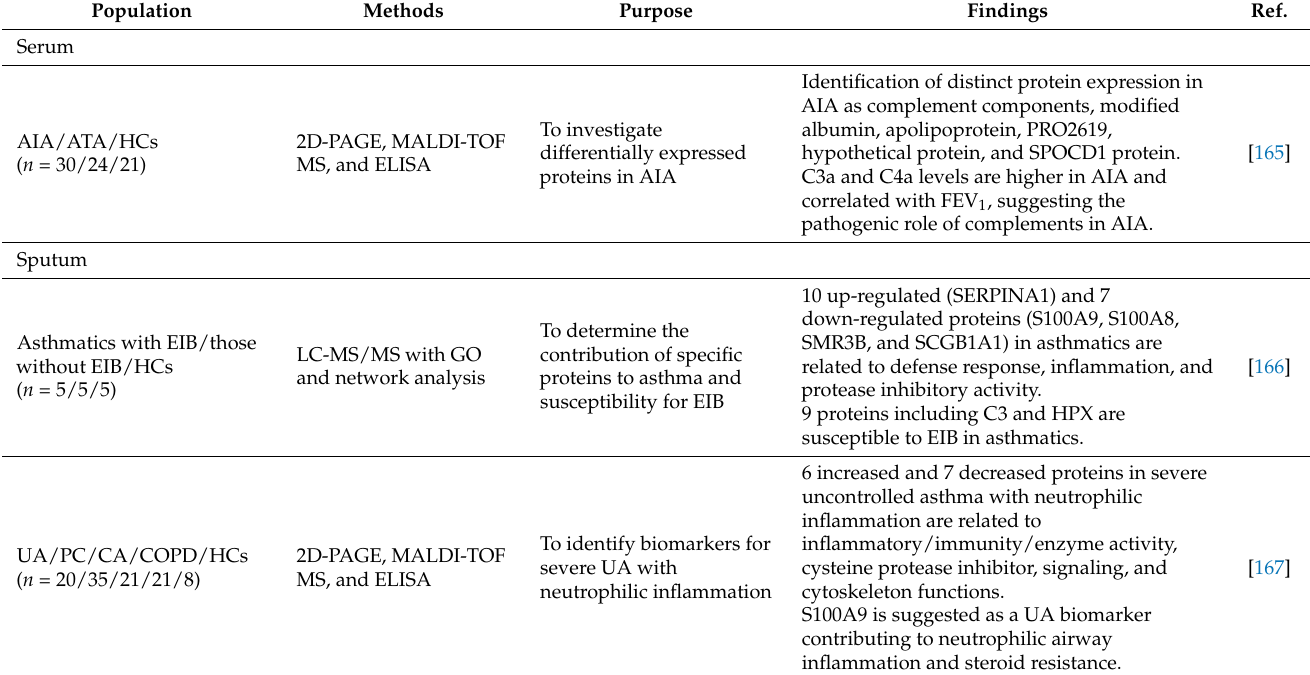
Table 3. Summary of proteomic analyses in adult